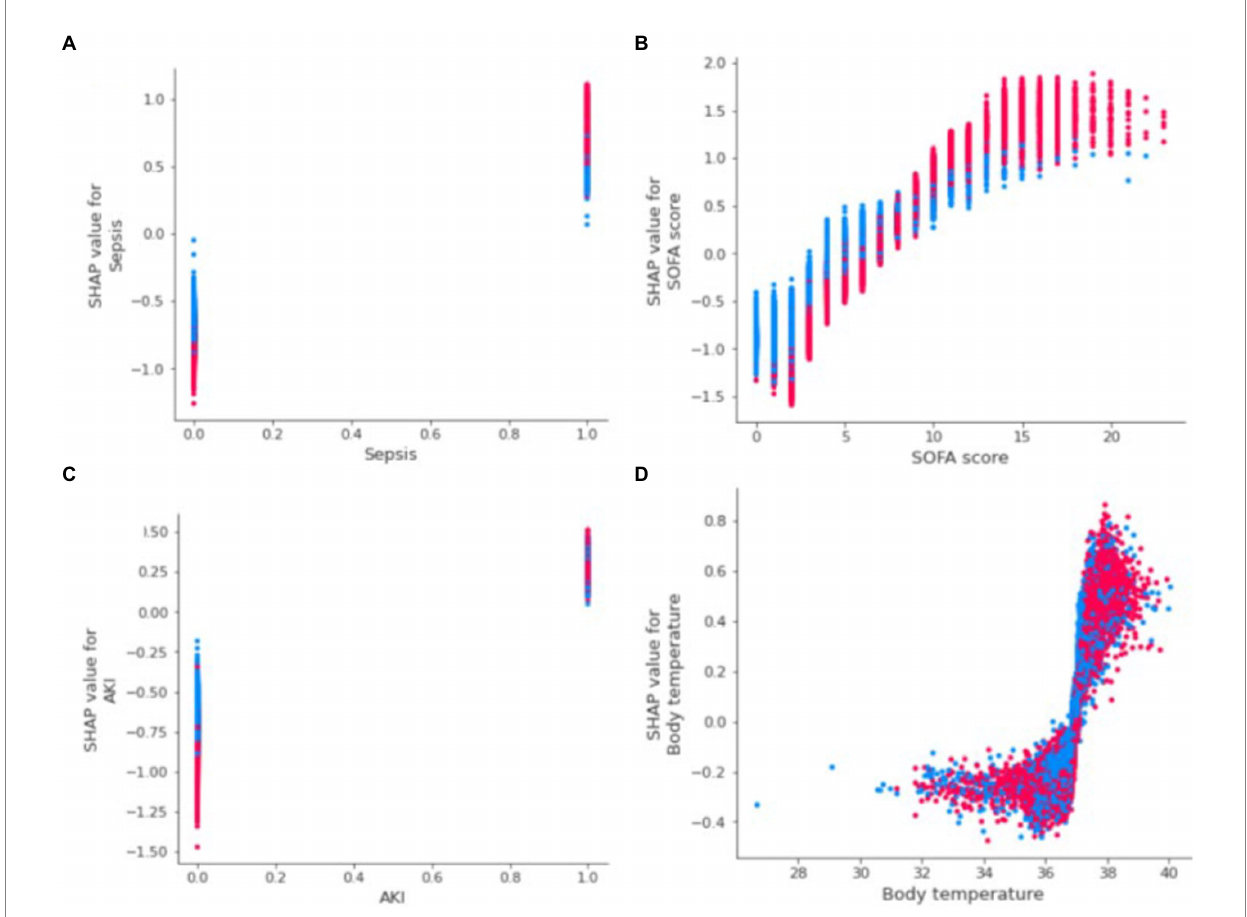
FIGURE 4 SHAP dependence plot of the first 4 variables influencing the XGBoost model. (A) Sepsis; (B) SOFA score; (C) AKI; (D) Body temperature. The probabilities of EN initiation increase when SHAP values of features exceed zero. AKI: acute kidney injury, SHAP: SHapley Additive explanation, SOFA: sequential organ failure assessment, XGBoost: eXtreme Gradient Boosting, EN: enteral